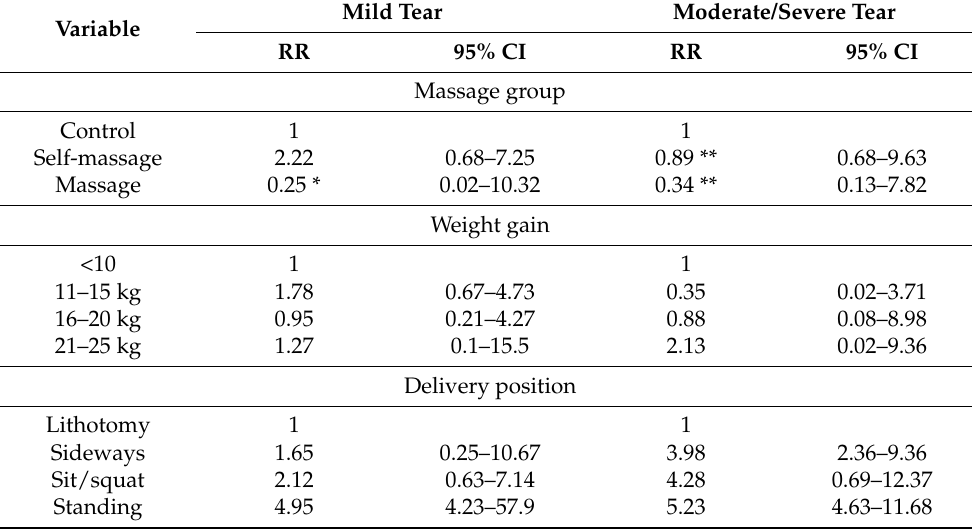
Table 3. Multinomial logistic regression of perineal tear in relation to massage group, weight gain, delivery position, analgesia and instrumental applied, adjusted by